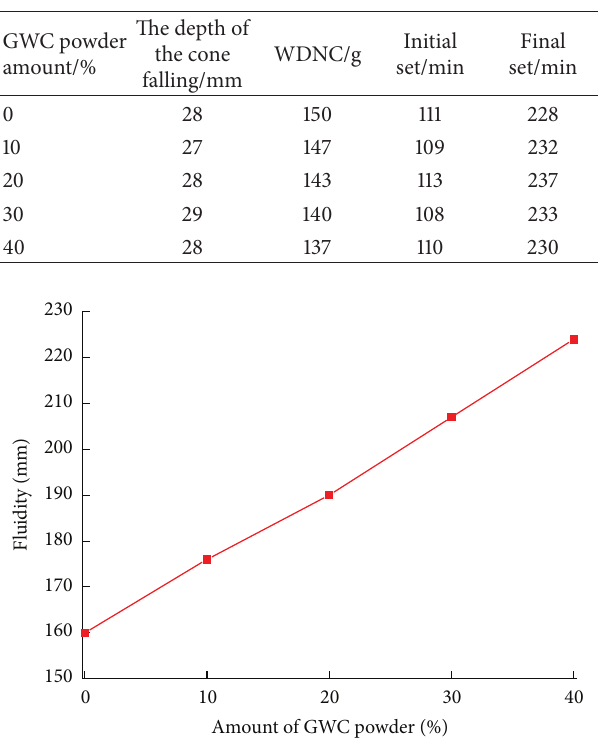
Figure 2: Change in fluidity of mortar with GWC powder